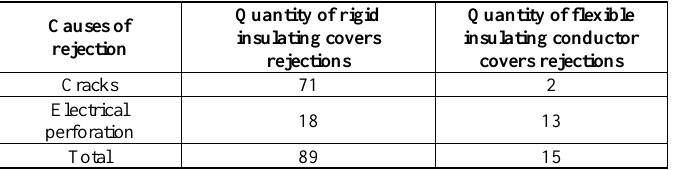
Table 5: Causes of rejection of insulating covers at the laboratory level.